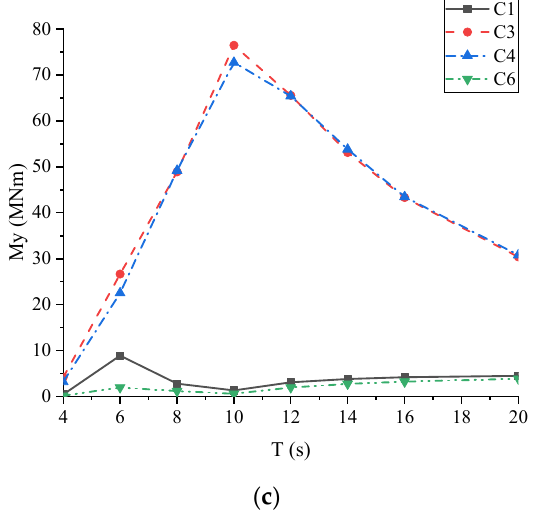
Figure 9. Main connector forces of each connector versus wave periods: ( a ) horizontal force; ( b ) shear force; ( c ) pitch bending moment.